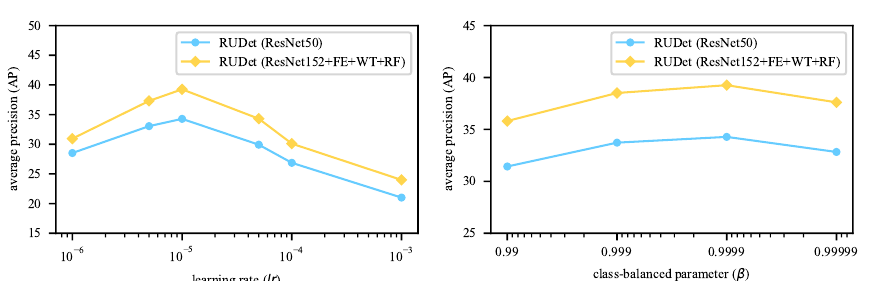
Figure 5. Different Average Precision (AP) values (the higher the better) with different hyperparame- ters, including the learning rate lr and the class-balanced parameter β